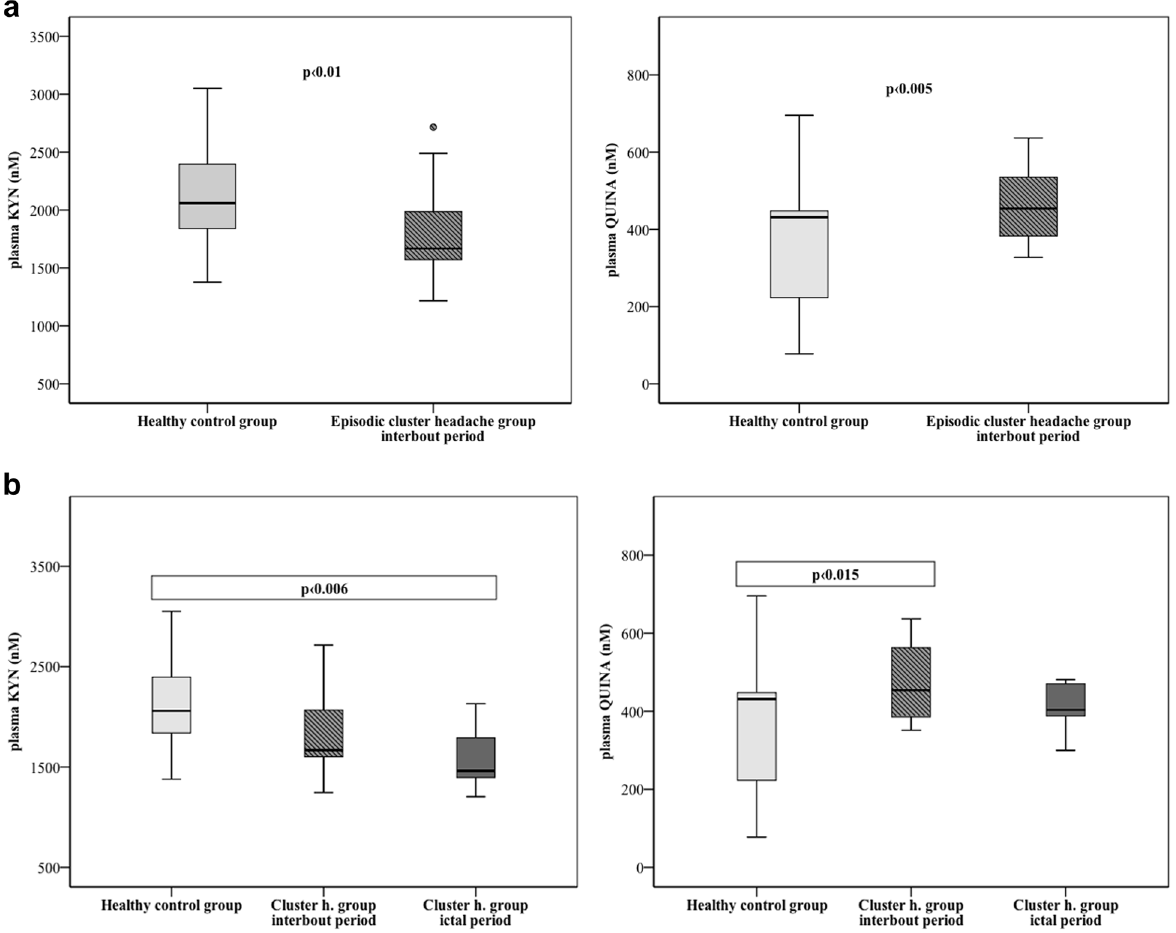
Fig. 1 a and b Significant changes of KYN and QUINA plasma levels in the interbout/ictal periods of CH patients compared to healthy control subjects. Median of data and value of interquartile range were represented in the figures. KYN: L-kynurenine, QUINA: quinolinic acid